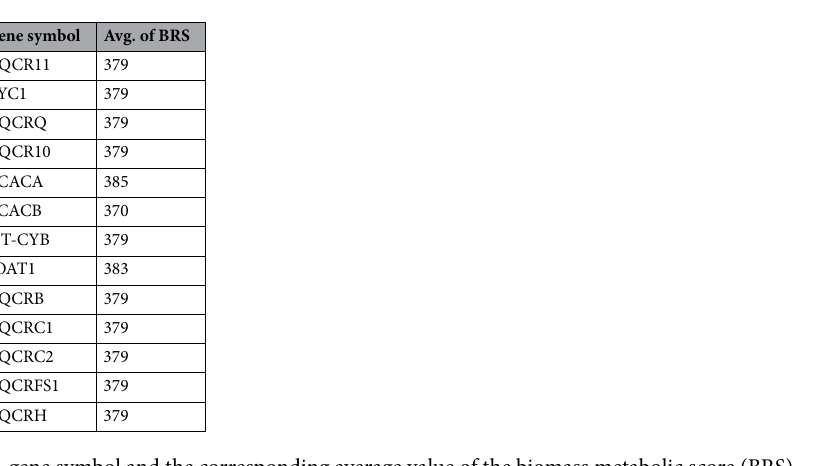
Table 1. Gene ID, gene symbol and the corresponding average value of the biomass metabolic score (BRS) across 60 cancer cell-line models of the cancer specific drug targets.